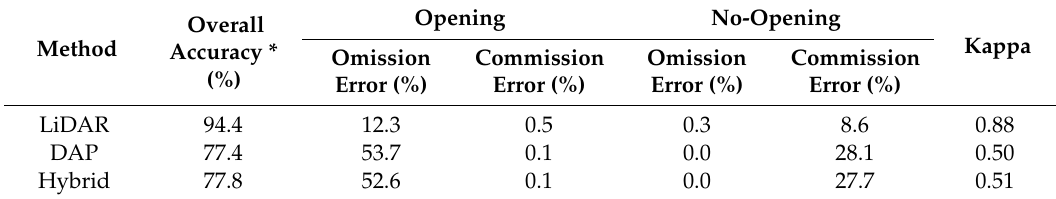
Table 4. Summary of opening and no-opening detection confusion matrices: mean overall accuracies, and errors of omission and commission. One-hundred sets of uncorrelated samples were used to produce these